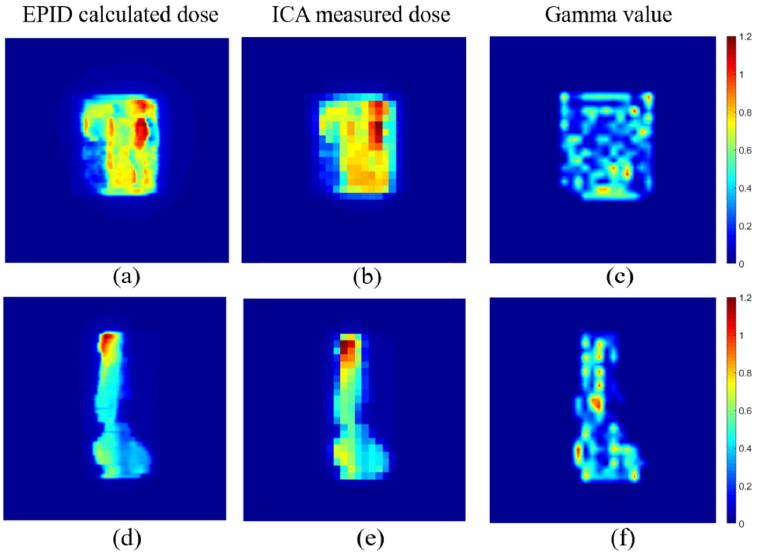
Figure 8. EPID calculated dose value ( a , d ), ICA measured dose value ( b , e ) and corresponding 2%/2 mm gamma value ( c , f ).